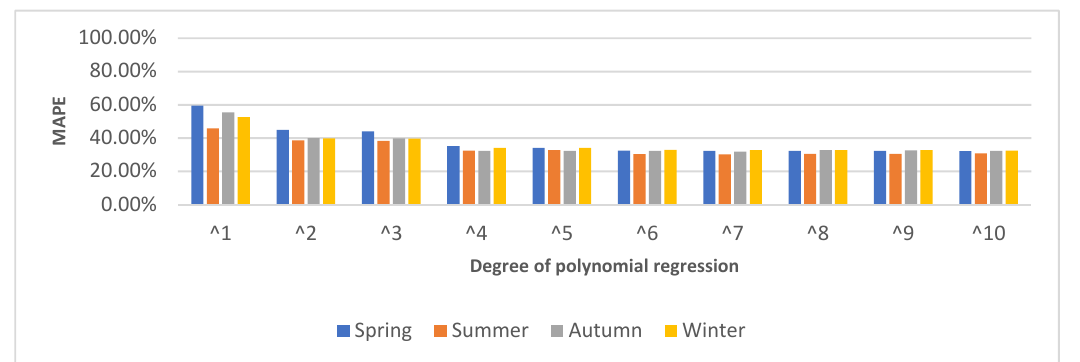
Figure 8. A comparison of orders of polynomial regression predictions.